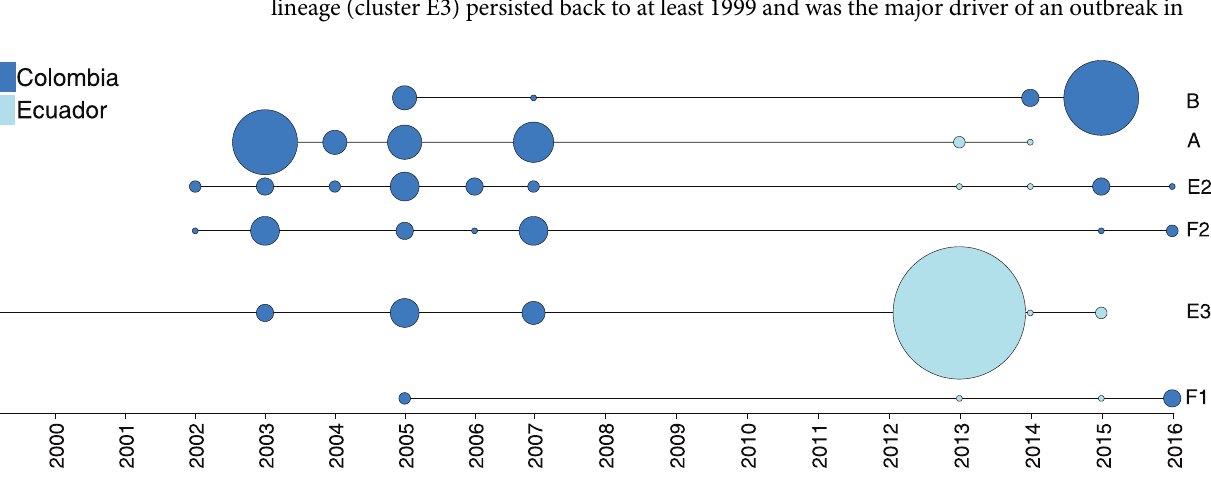
Fig 4. Spatiotemporal distribution of long-persisting clonal clusters across Ecuador and Colombia. A combined analysis of recent whole-genome sequencing data (2013–2017) and older longitudinally sampled parasites genotyped at 250 SNPs (1993–2007; N = 325 [32]) identified six clonal clusters that have persisted in the region for a decade or longer. Four of these clusters were sampled in both Colombia and Ecuador, albeit not within the same year. Clonal clusters detected in a given year are depicted by the vertices with the size of the vertex corresponding to the number of samples. S6C Fig breaks down the clonal components by within-country